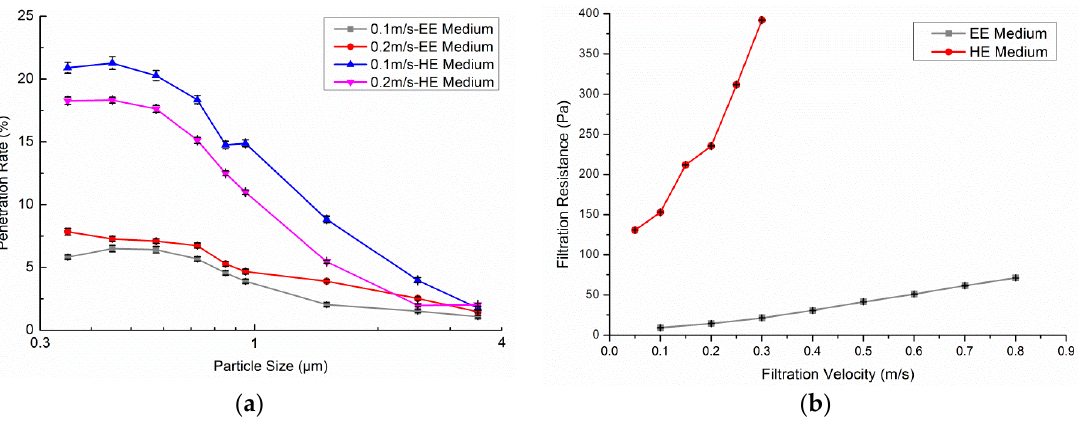
Figure 6. Filtration characteristics of clean EE and HE medium. ( a ) Size resolved penetration rate; ( b ) filtration resistance. ( b ) filtration